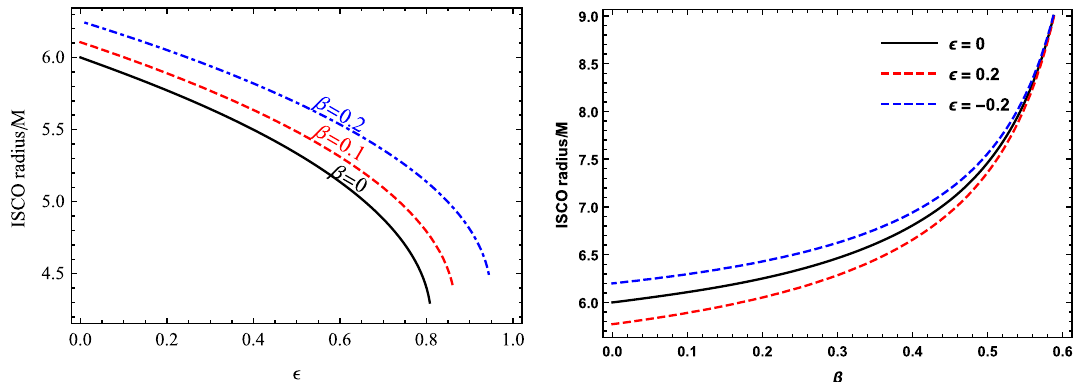
Fig. 8 Dependence of the ISCO radius of test particles orbiting at the equatorial plane around a quasi-Schwarzschild black hole from the deviation for given β (left panel) and magnetic coupling parameters for given (cid:2) (right